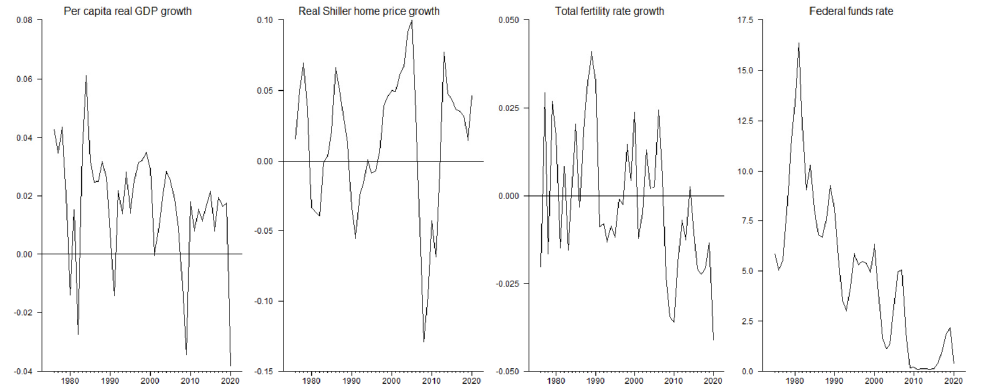
Figure 1. Time series graphs of the variables used in the baseline SVAR.